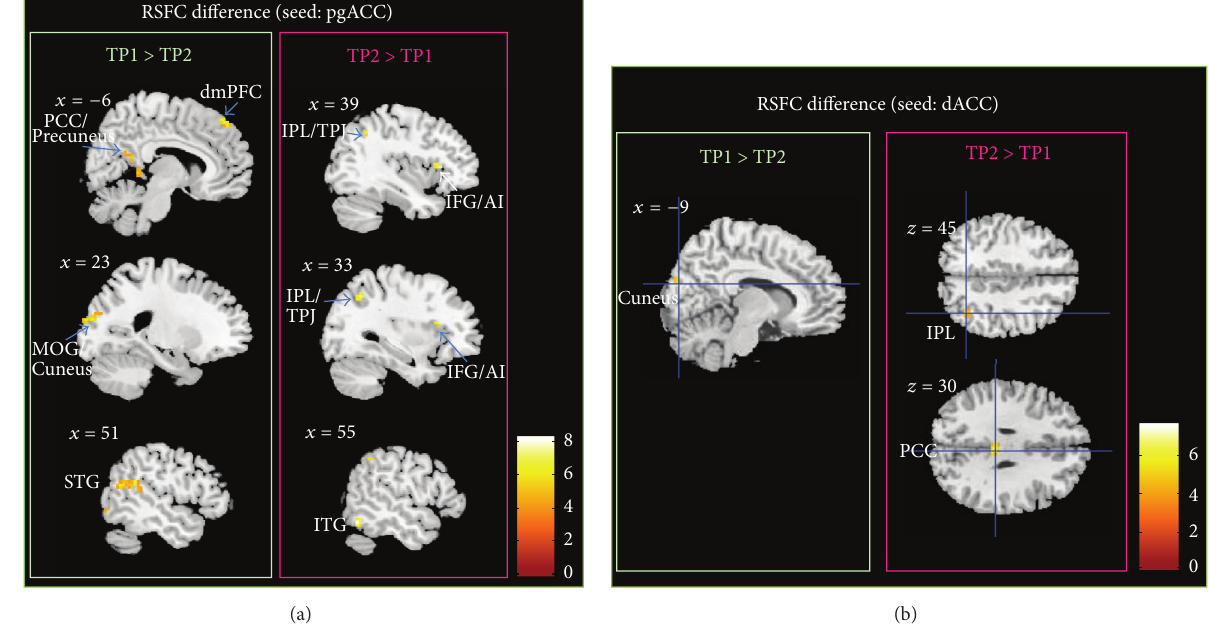
Figure 3: (a) Longitudinal seed-based RSFC results (seed = pgACC) ( 𝑝 < 0.05 , FWE-corrected). Bar plot represents the 𝑡 -values. White labels indicate the coordinate of each slice in the MNI frame of reference ( 𝑥,𝑧 ). (b) Longitudinal seed-based RSFC results (seed = dACC) ( 𝑝 < 0.05 , FWE-corrected). Bar plot represents the 𝑡 -values. White labels indicate the coordinate of each slice in the MNI frame of reference ( 𝑥,𝑧 ).